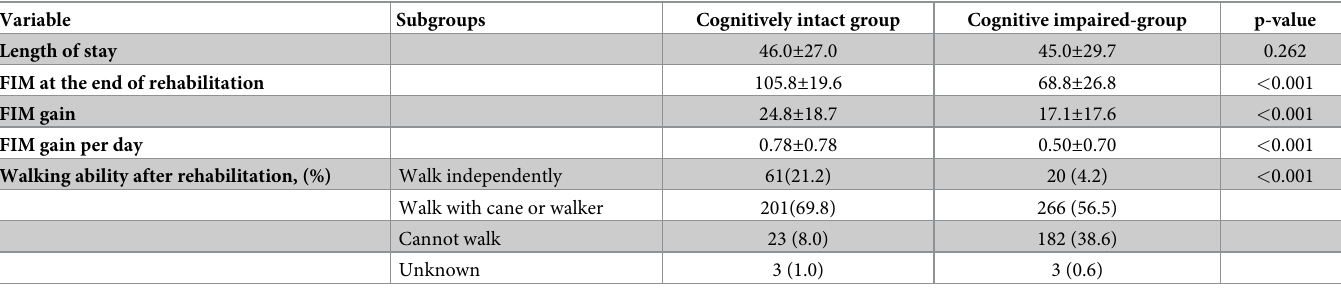
Table 2. Effect of